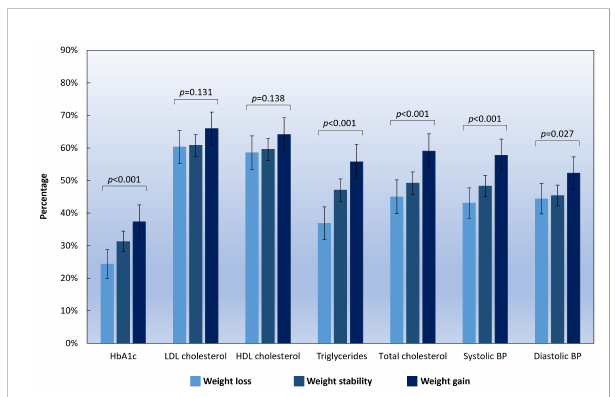
FIGURE 1 Percentage of patients who had worsening CV risk factors according to different weight change categories. Note: HbA1c, haemoglobin A1c; LDL, low-density lipoprotein; HDL, high-density lipoprotein; BP, blood pressure. Weight gain was de fi ned as an increase of ≥ 3% in body weight, and weight loss was de fi ned as a decrease of ≥ 3% in body weight. Weight stability was de fi ned as having a weight change of <3% in body weight during the study period. Error bars indicate 95% con fi dence